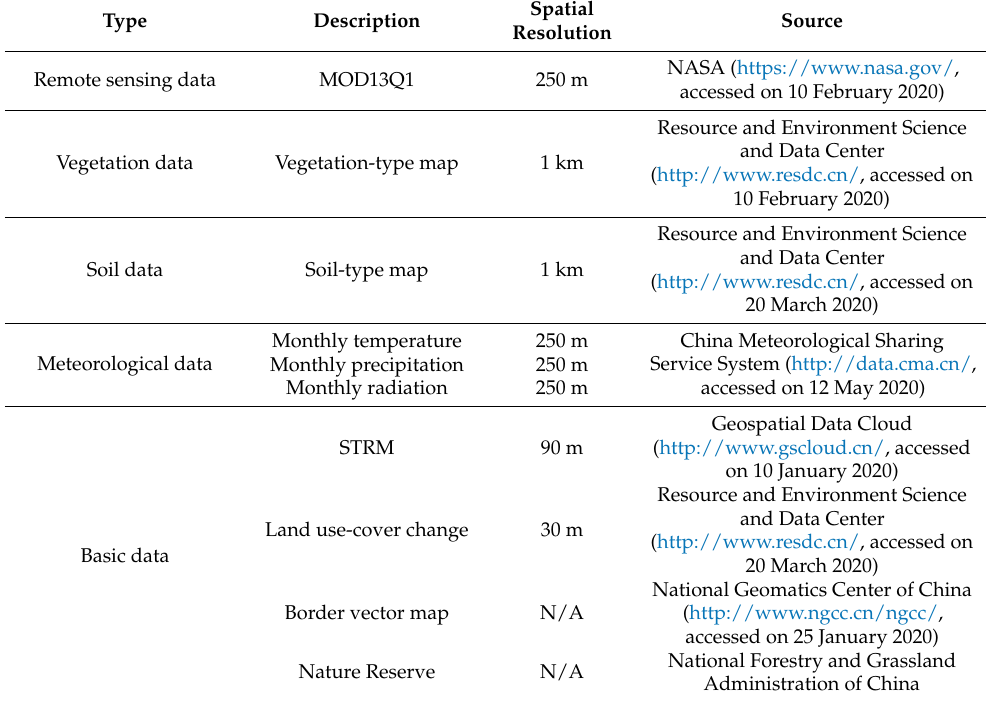
Table 1. Data description and